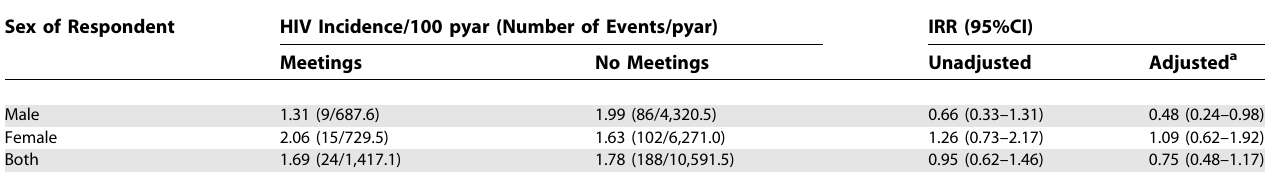
Table 6. HIV Incidence and IRRs by Meeting Attendance and Sex Sex of